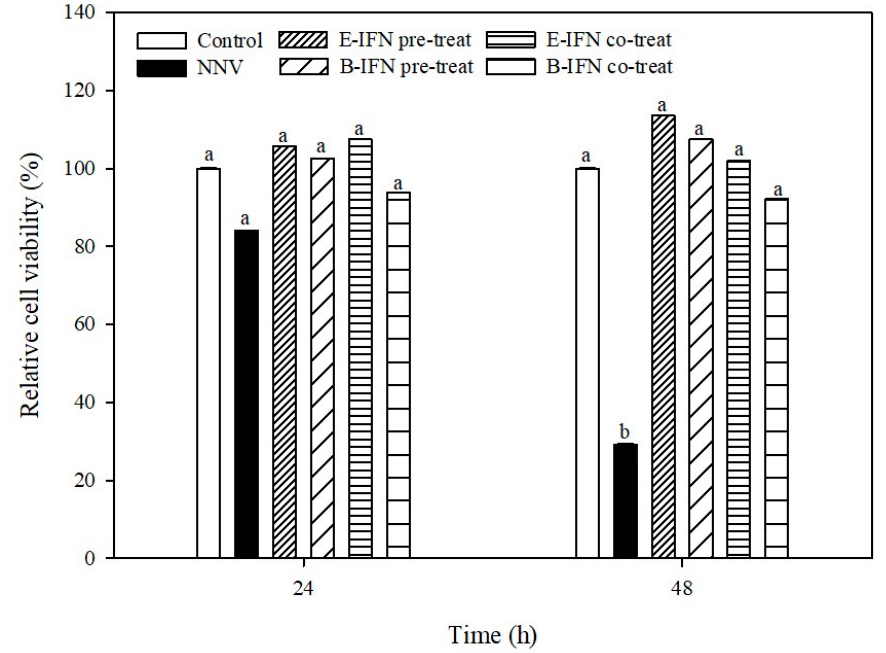
Figure 7. The antiviral effects of the IFNs overexpressed in E. coli and B. subtilis in the pre-treatment and co-treatment to the GK cells. The GK cells were pre-treated and co-treated with NNV (10 4.5 TCID50/0.1 mL, 1:100 diluted, 100 μ L/per well) and IFN at 1 μ g/mL for 24 and 48 h. The cell viability was determined by MTT assay. Data are expressed as mean ± SD of triplicate samples, and Different letters in each grouped bars indicated significant differences ( p < 0.05).